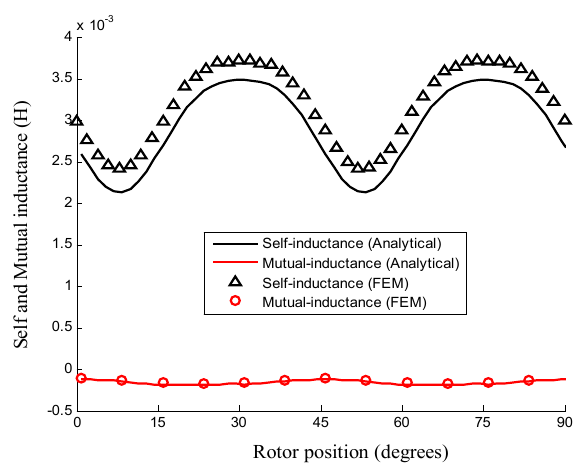
Figure 14. Self and mutual inductance of a phase.